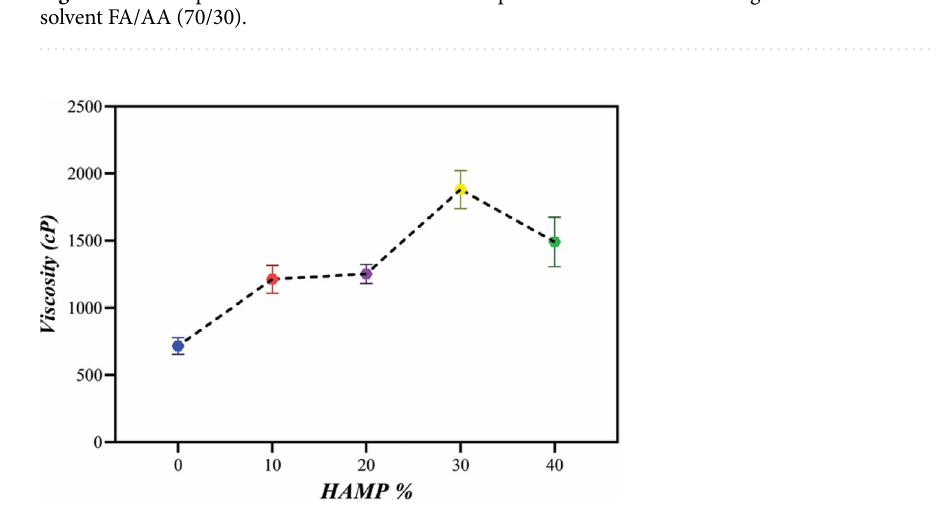
Figure 3. The viscosity of electrospinning solutions with different amounts of